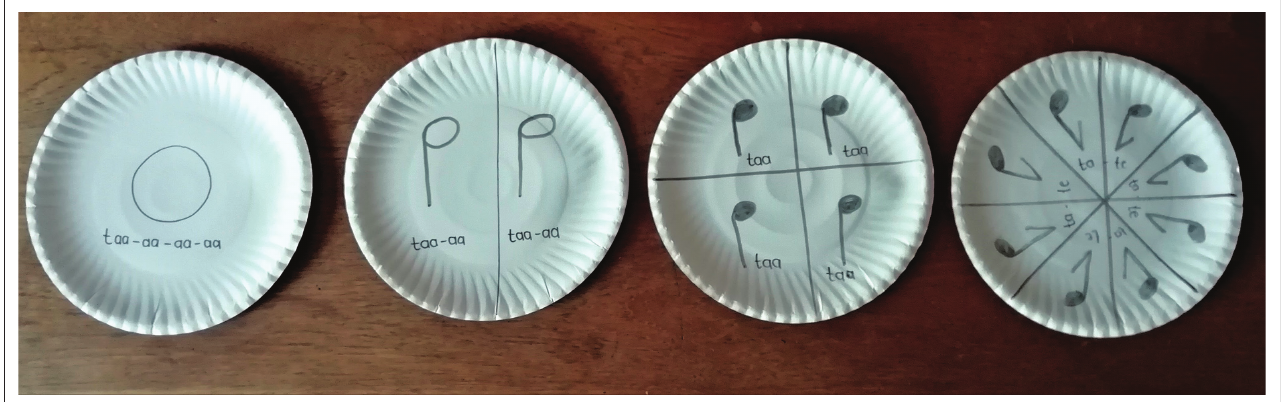
FIGURE 4: Photograph of paper plate learning support materials to visually represent different note values.